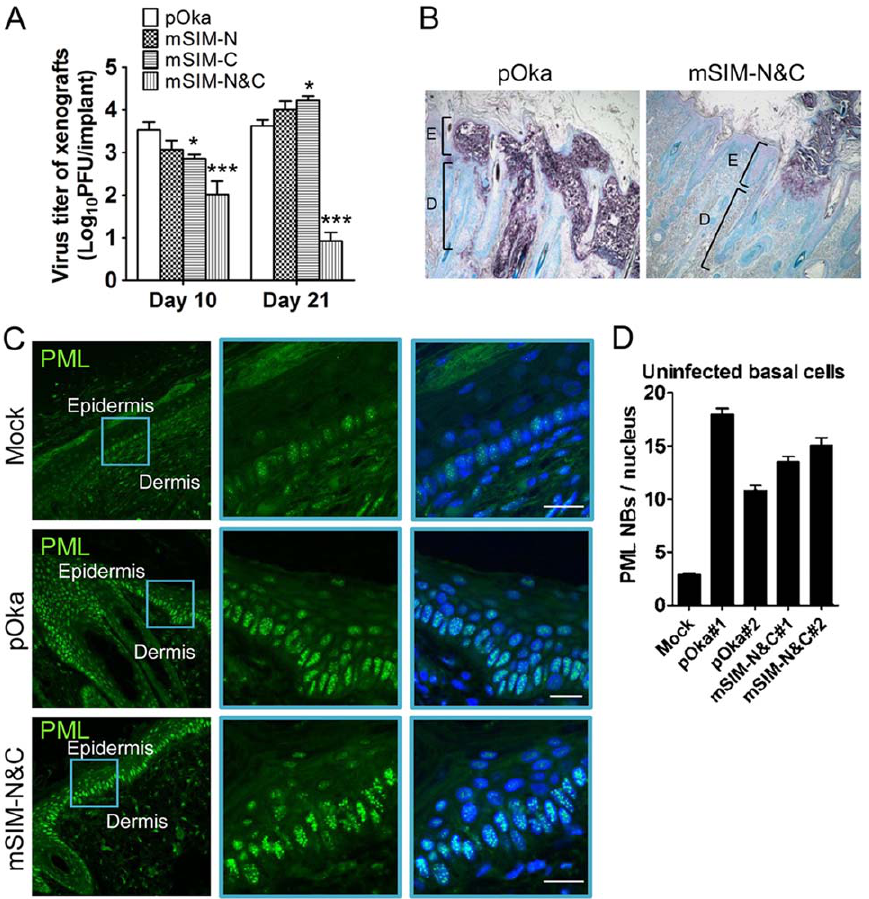
Figure 6. ORF61 SIMs are critical for VZV virulence in skin. (A) Replication of pOka and ORF61 SIM mutant viruses in human skin xenografts in SCID mice (inoculum: , 8 6 10 4 PFU/xenograft). The graph shows the mean titer 6 SEM of xenografts that yielded viruses at 10 and 21 days post- infection. *, p , 0.05; ***, p , 0.001; vs pOka (two-way ANOVA). (B) Lesions in skin xenografts infected with pOka- or pOka-mSIM-N&C for 21 days were identified by VZV gE expression. Nuclei were stained with methyl green. Magnification, 5x. Structures of epidermis [E] and dermis [D] are indicated. (C) Confocal microscopy of uninfected cells from mock-infected skin xenografts (upper panels) and pOka- or pOka-mSIM-N&C-infected skin xenografts (middle and lower panels). These skin sections were stained for PML proteins (green) and nuclei (blue). Epidermal and dermal layers are indicated. Middle and right images of each panel are zoom-in of the blue square area from the left image. Scale bars: 20 m m. (D) PML NB frequency (mean 6 SEM) in uninfected basal cells from each of two skin xenografts infected with either pOka or pOka-mSIM-N&C was quantified and compared with a mock-infected xenograft (number of nuclei examined: Mock, N=112; pOka # 1, N=99; pOka # 2, N=93; mSIM-N&C # 1, N=109; mSIM-N&C # 2, N=85).